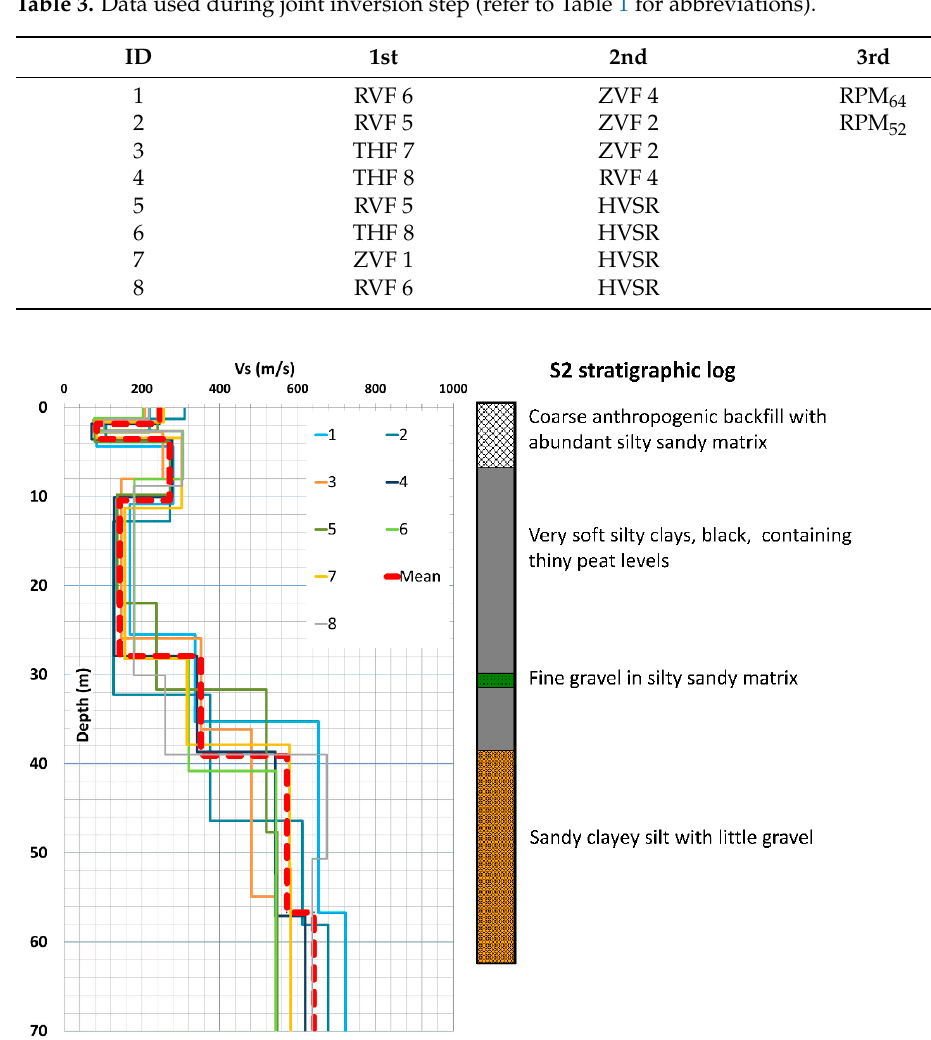
Figure 23. Shear waves velocity profiles up to 60 m and the S2 stratigraphic